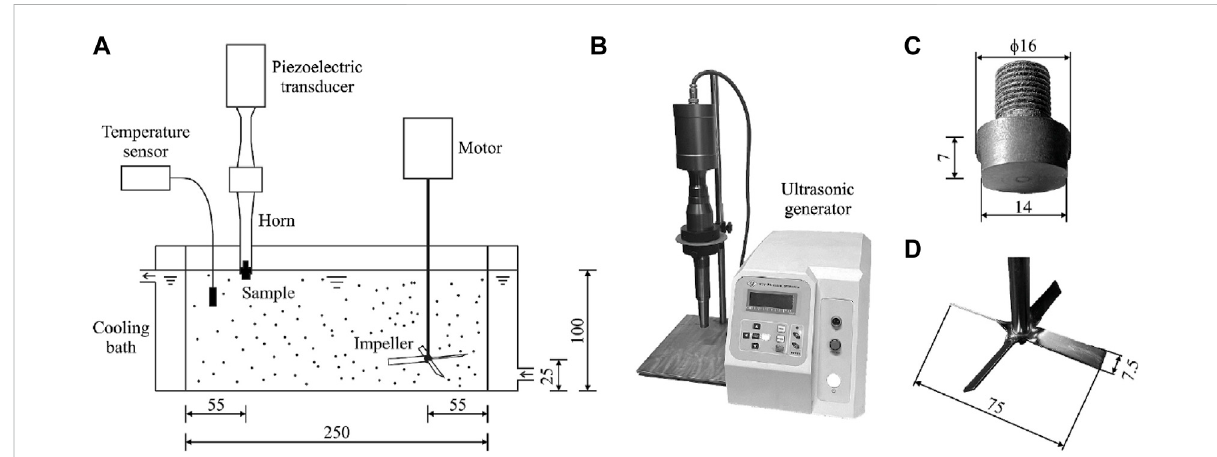
FIGURE 3 Vibratorytestfacility(Suetal.,2021). (A) Schematicdiagramoftheexperimentalsetup; (B) ultrasonicdevice; (C) sampledimensions; (D) impeller dimensions (mm).